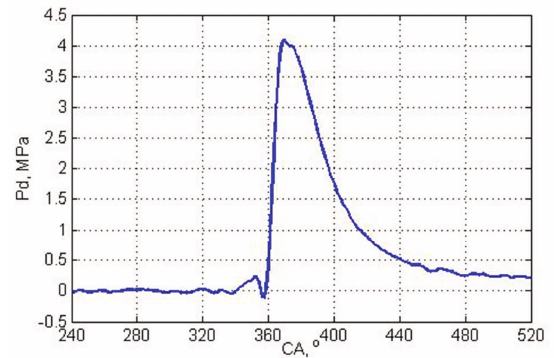
Fig. 3. Differential pressure at 100% EGR valve open (1000 rpm, 190